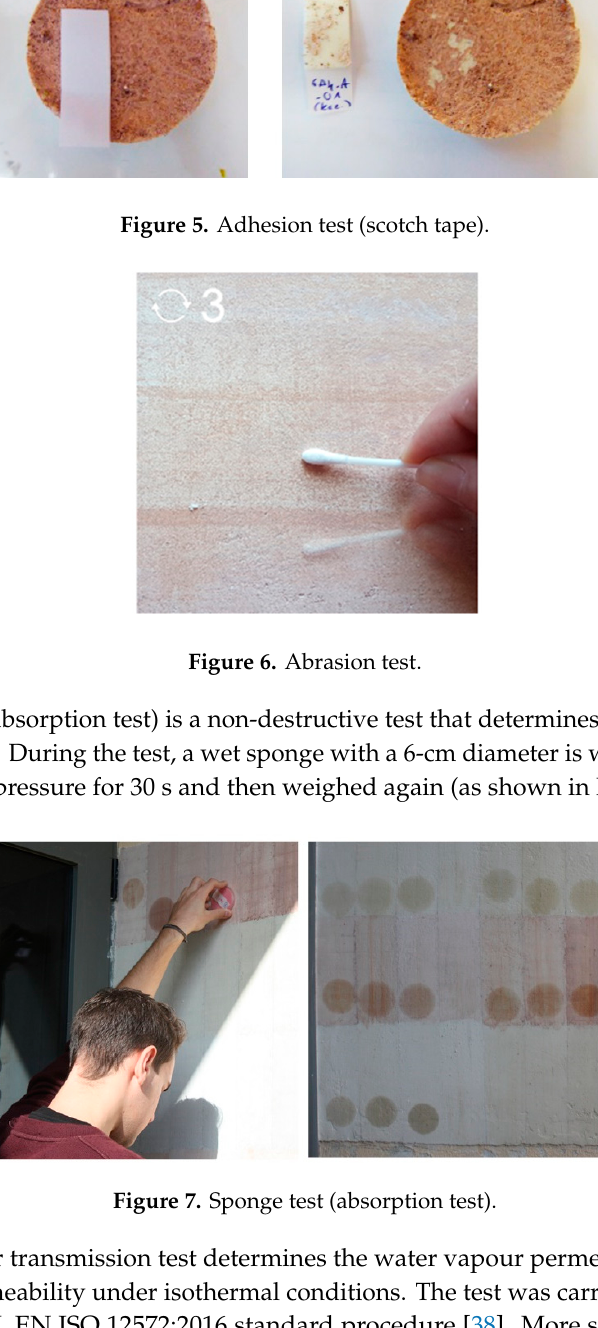
Figure 7. Sponge test (absorption test).